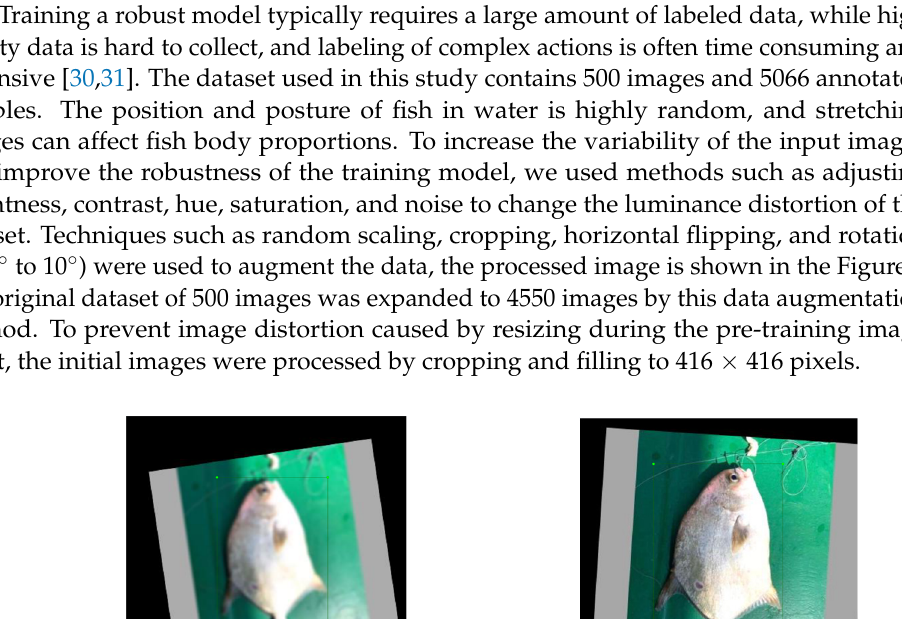
Figure 2. Schematic diagram of image-acquisition system, image preprocessing, model improving, model training, and fish skin disease detection.